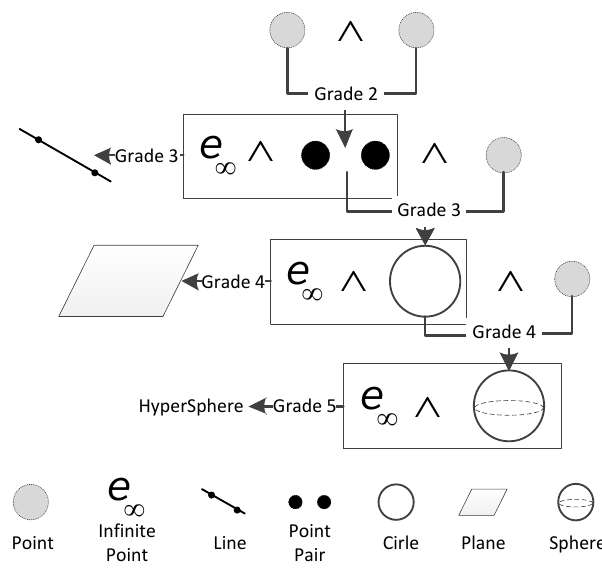
Figure 1. Grassmann structure that contains dimensional elements, where ^ denotes an outer product.